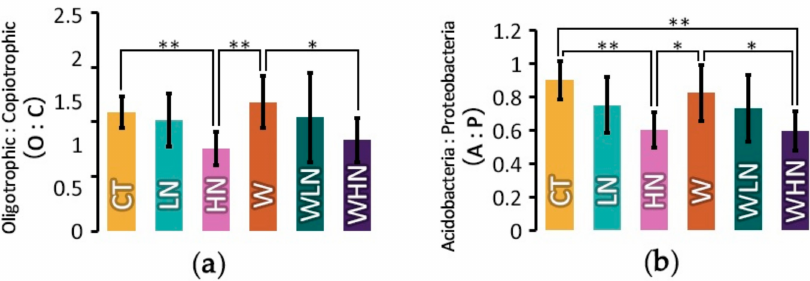
Figure 5. Oligotrophic:copiotrophic (O:C) and Acidobacteria:Proteobacteria (A:P) ratios under warming and N addition. ( a ) O:C ratio and ( b ) A:P ratio (in (a) and (b), * p ≤ 0.05 and ** p ≤ 0.01,